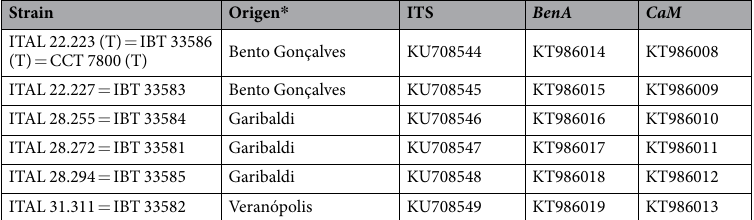
Strain Origen * ITS BenA CaM